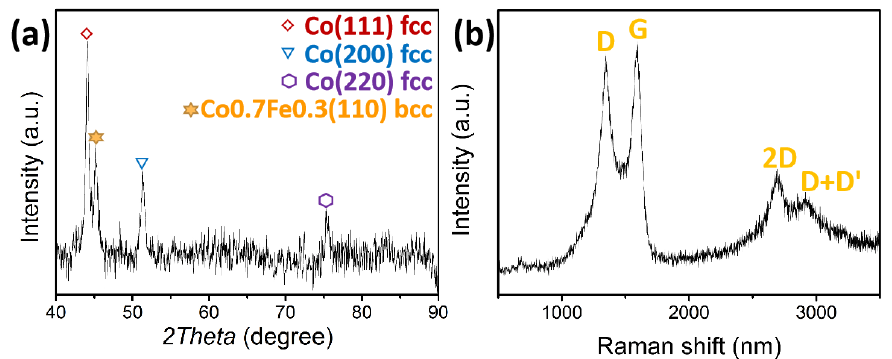
Figure 1. XRD pattern ( a ) and Raman spectrum ( b ) of sample 1.